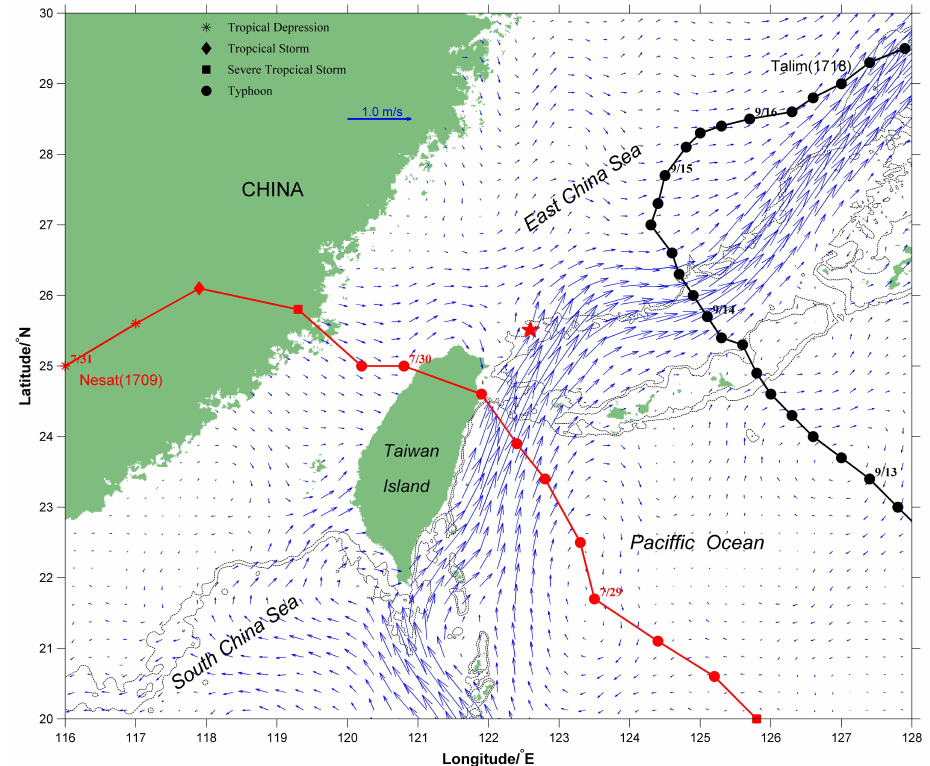
Figure 1. Location of the mooring station (the red star). The dashed black contours mark the 500 m and 1000 m isobaths. The red and black solid lines represent the track of typhoon Nesat and Talim according to typhoon information accessed from the Japan Meteorological Agency (JMA). The asterisks (tropical depression), diamonds (tropical storm), squares (severe tropical storm), and circles (typhoon) denote the six-hour position of the typhoons. The blue arrows show the mean geostrophic current according to the AVISO climatology